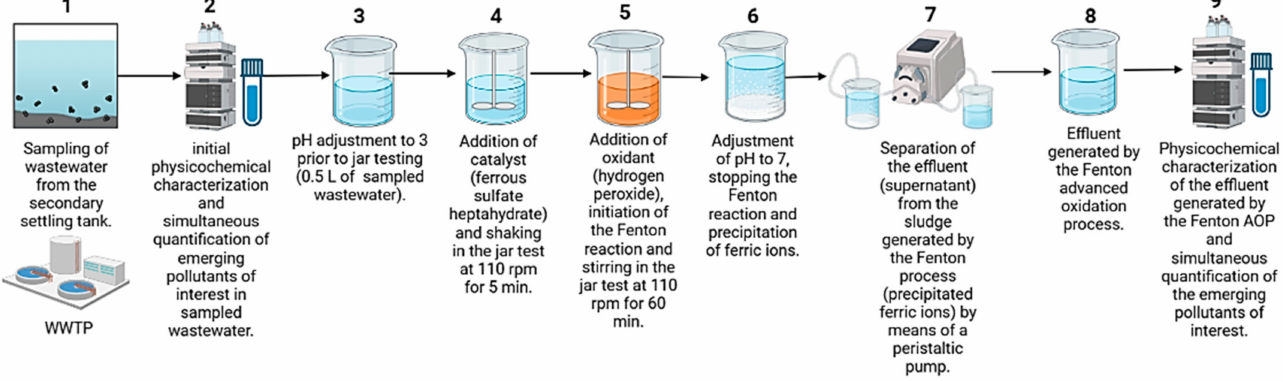
Figure 2. Experimental setup.